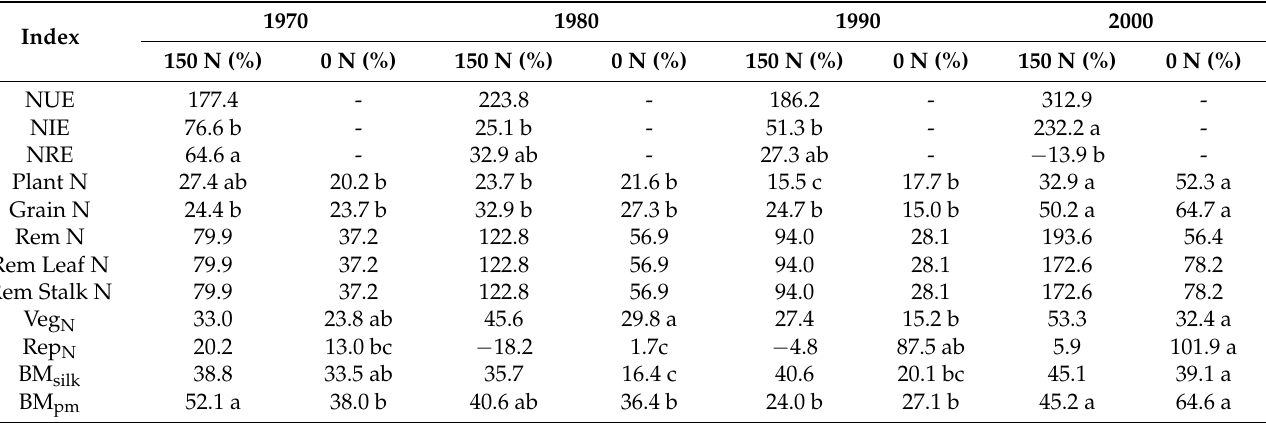
Table 5. The mean mid-parent heterosis value of NUE and related parameters of maize hybrids in different